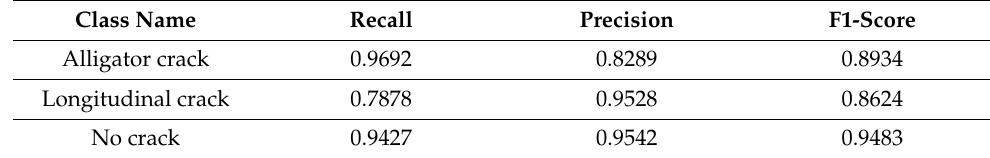
Table 5. Performance metrics for each class of VGG-19 model.